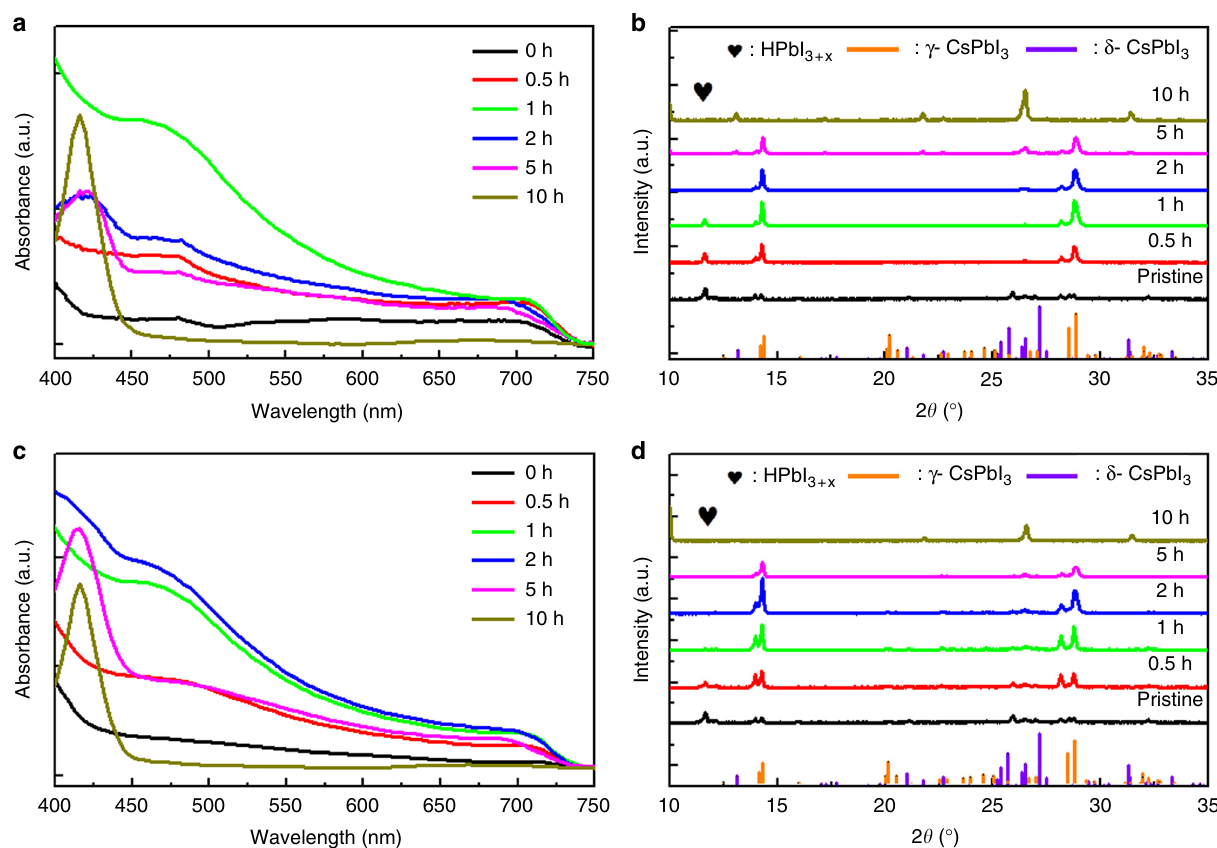
Fig. 2 Performance of the fabricated fi lms: Comparison of the CsPbI 3 fi lms without and with PEAI annealed at 150 °C for various times: a , c optical absorption spectra; b , d XRD